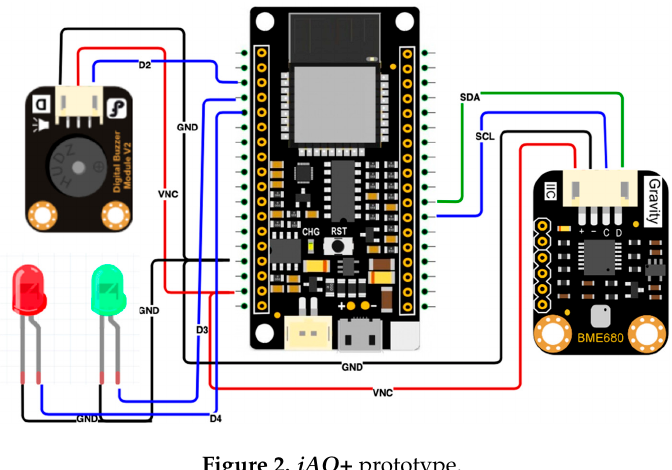
Figure 2. iAQ+ prototype.